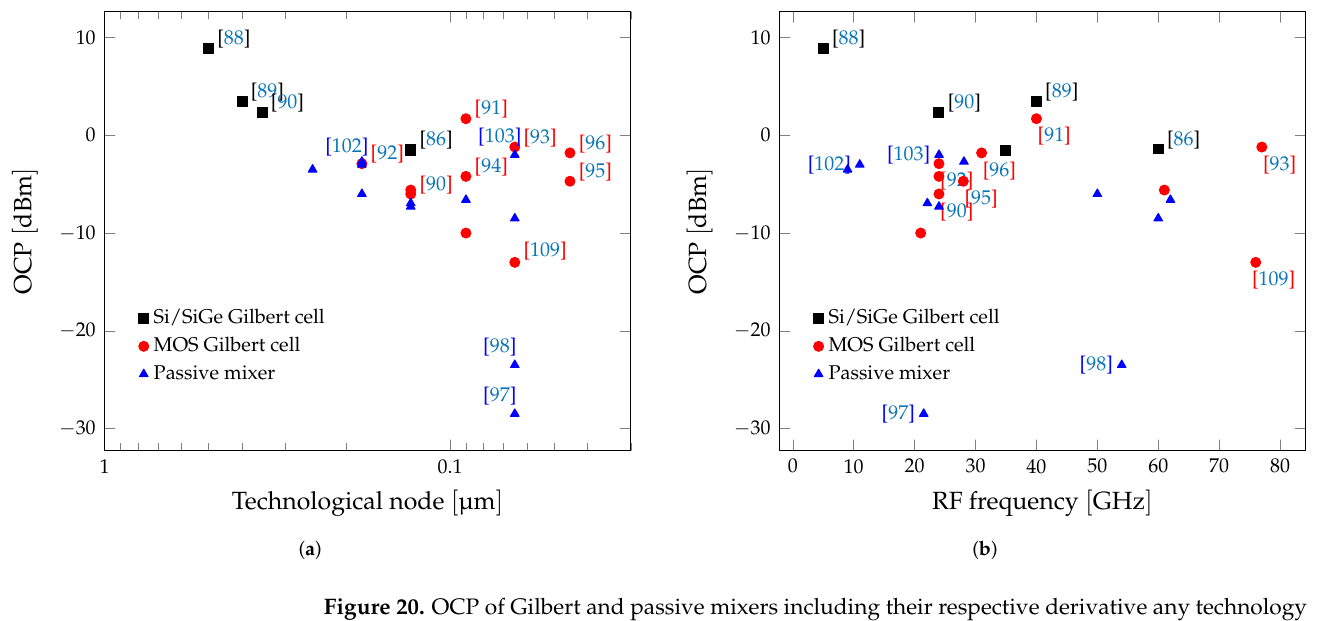
Figure 20. OCP of Gilbert and passive mixers including their respective derivative any technology combined: ( a ) OCP versus technological node and ( b ) OCP versus RF operating